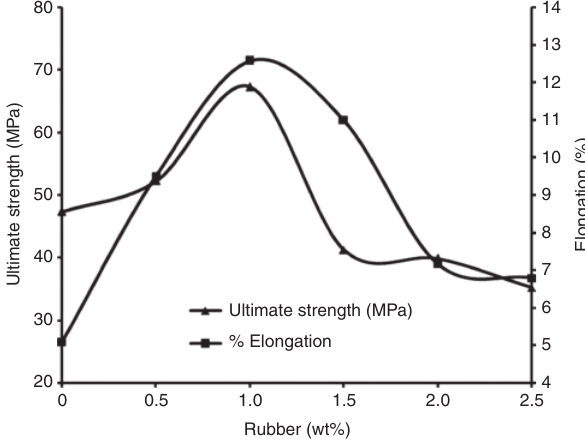
Figure 4 Mechanical properties of cured epoxy filled with different weight percentages of